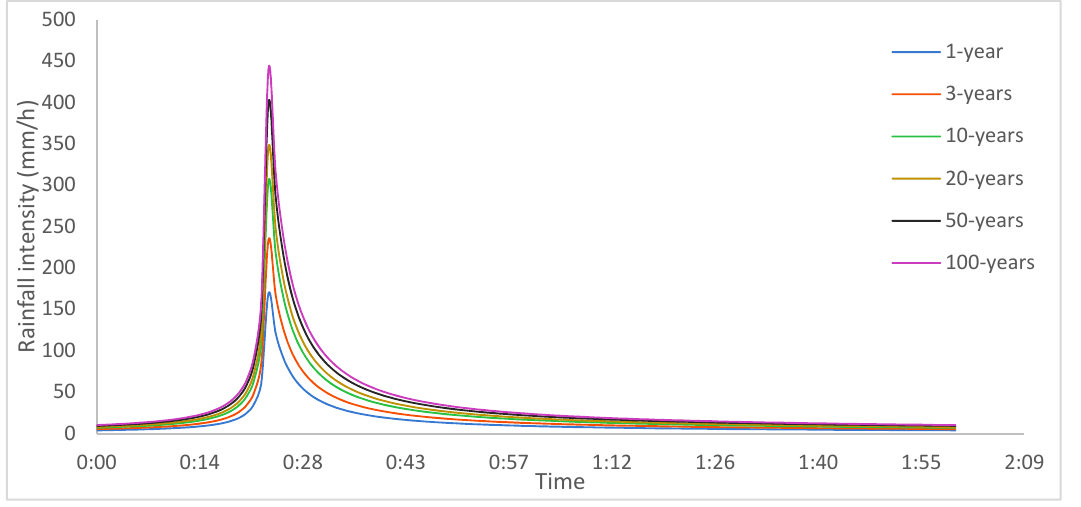
Figure 3. Design storms for Changchun.